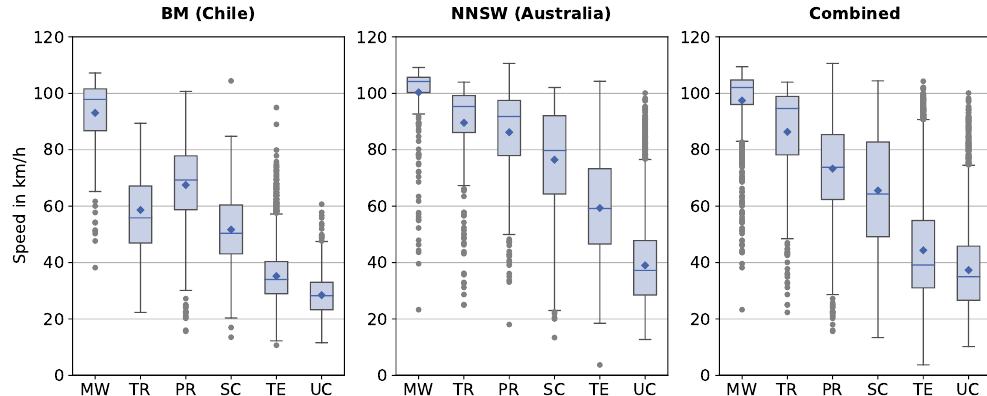
Figure 2. Boxplots of the speed distribution for each road class of the reference data (GD-API) for the BM dataset (Chile) and the NNSW dataset (Australia). Road classes: MW— Motorway , TR— Trunk , PR— Primary , SC— Secondary , TE— Tertiary , UC— Unclassified . The blue diamonds in the boxes symbolize the respective median, the blue lines the respective mean value. The lower limit of each box is the 25th percentile ( Q 1), the upper limit the 75th percentile ( Q 3) so that the difference builds the interquartile range ( IQR ). Whiskers extend to Q 1 − 1.5 ∗ IQR and Q 3 + 1.5 ∗ IQR . Any points